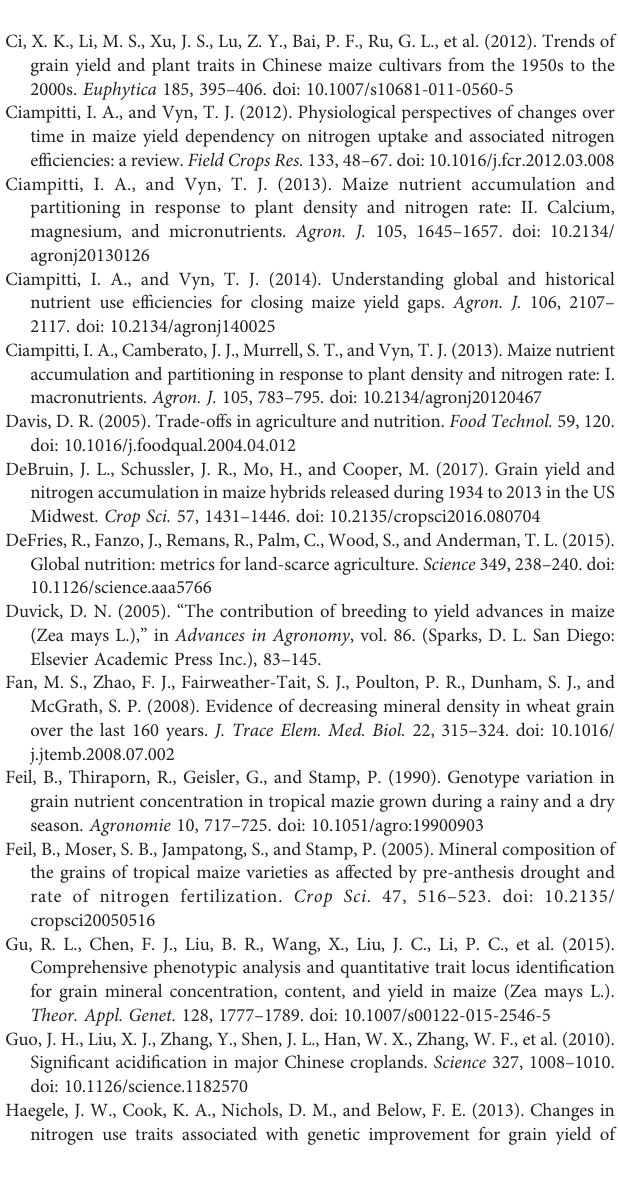
FIGURE S1 | Relationship between the year of cultivars release, grain yield, and grain nutrient (N, Cu, Fe, K, Mg, Mn, P and Zn) concentrations. Data were collected in Shun-Yi (SY). Closed and open circle denote the mean ± SD of three and four replicates in 2010 and 2011, respectively. *, ** denote signi fi cance at the 0.05 and 0.01 probability levels,